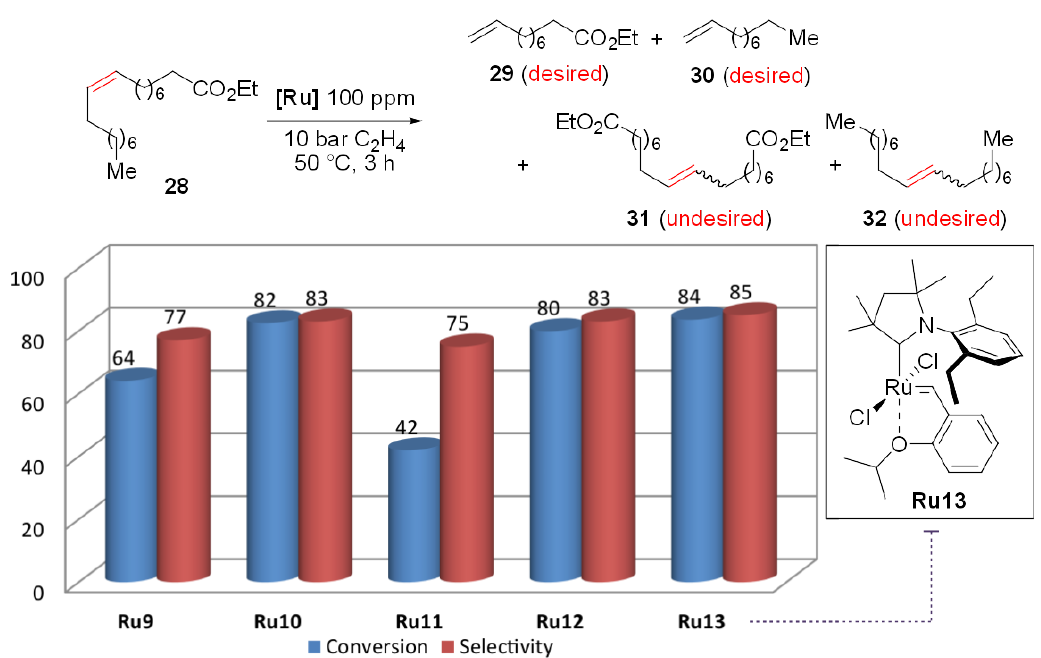
Figure 8. Ethenolysis of ethyl oleate ( 28 ) with ethylene grade 3. Conversion and selectivity were calculated from gas chromatography (GC). Conversion = 100 − ((final moles of 28 ) × 100 / (initial moles of 28 )); Selectivity = 100 × (moles of 29 + 30 ) / ((moles of 29 + 30 ) + (2 × moles of 31 + 32 )).